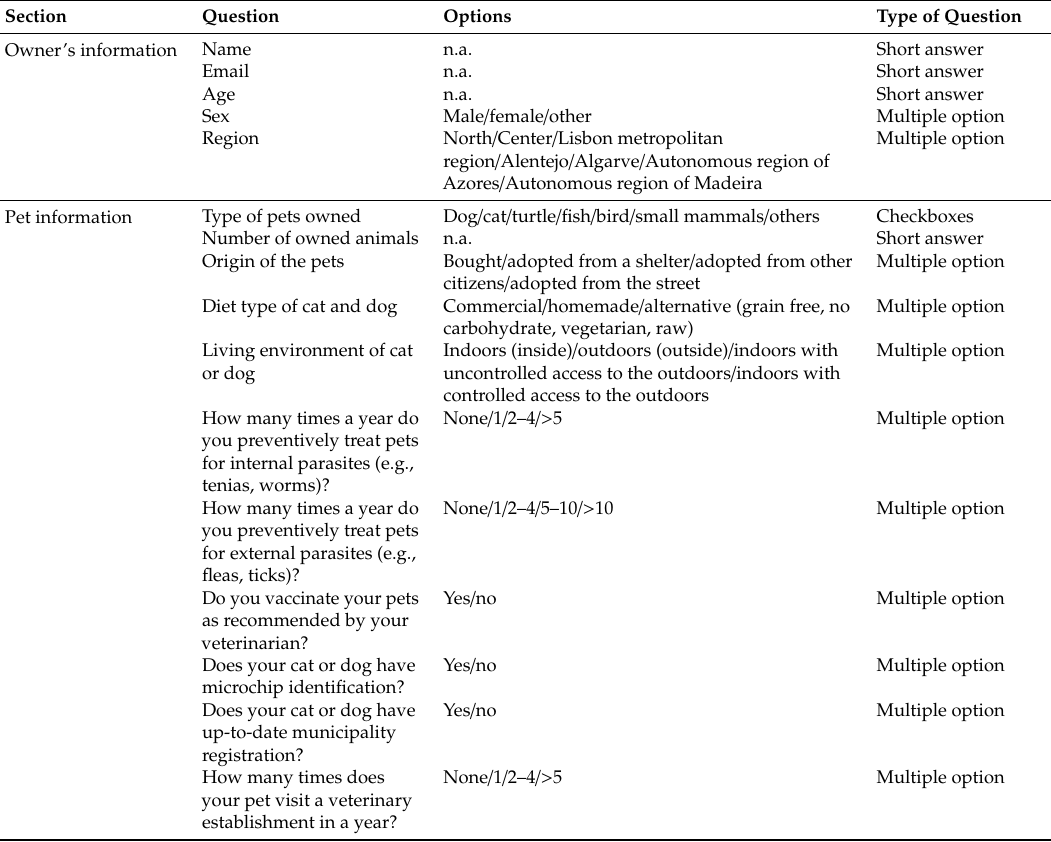
Table A1. Questionnaire used to assess Portuguese pet owners’ husbandry practices, opinions and self-reported information